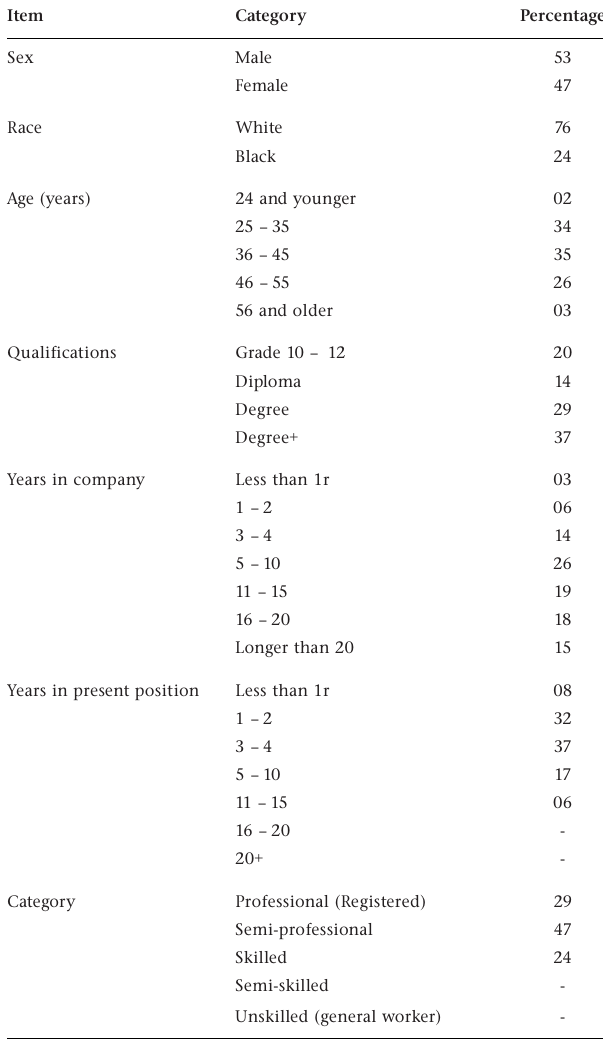
Table 1 indicates that the majority of the study population